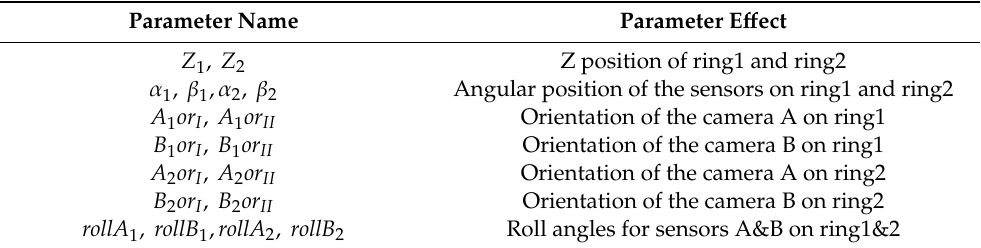
Table 4. Parameters used in the case study to model the solution space for the eight sensors.